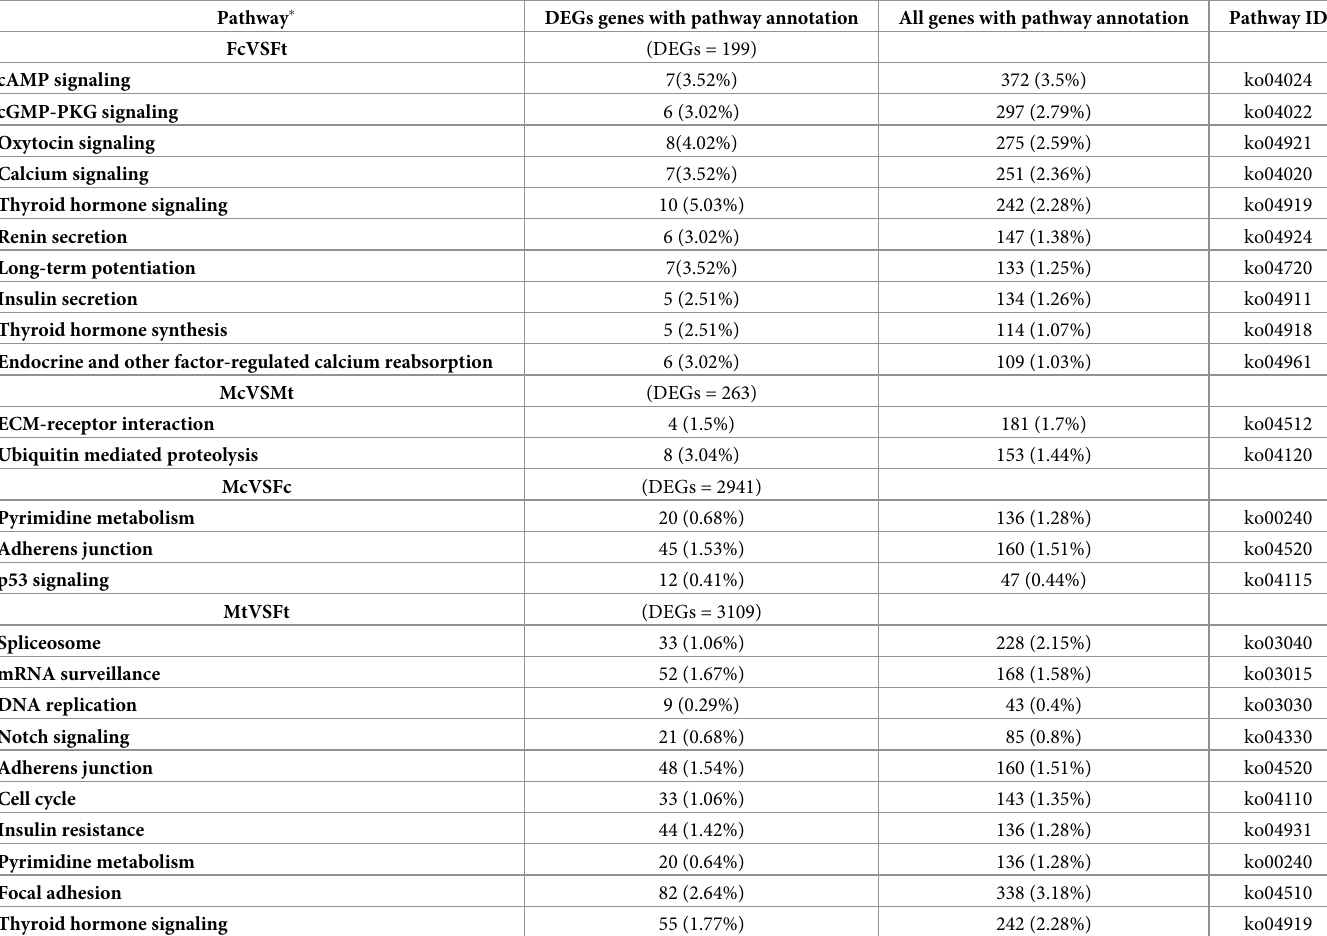
Table 3. Selected KEGG pathway analysis from DEGs based on de novo